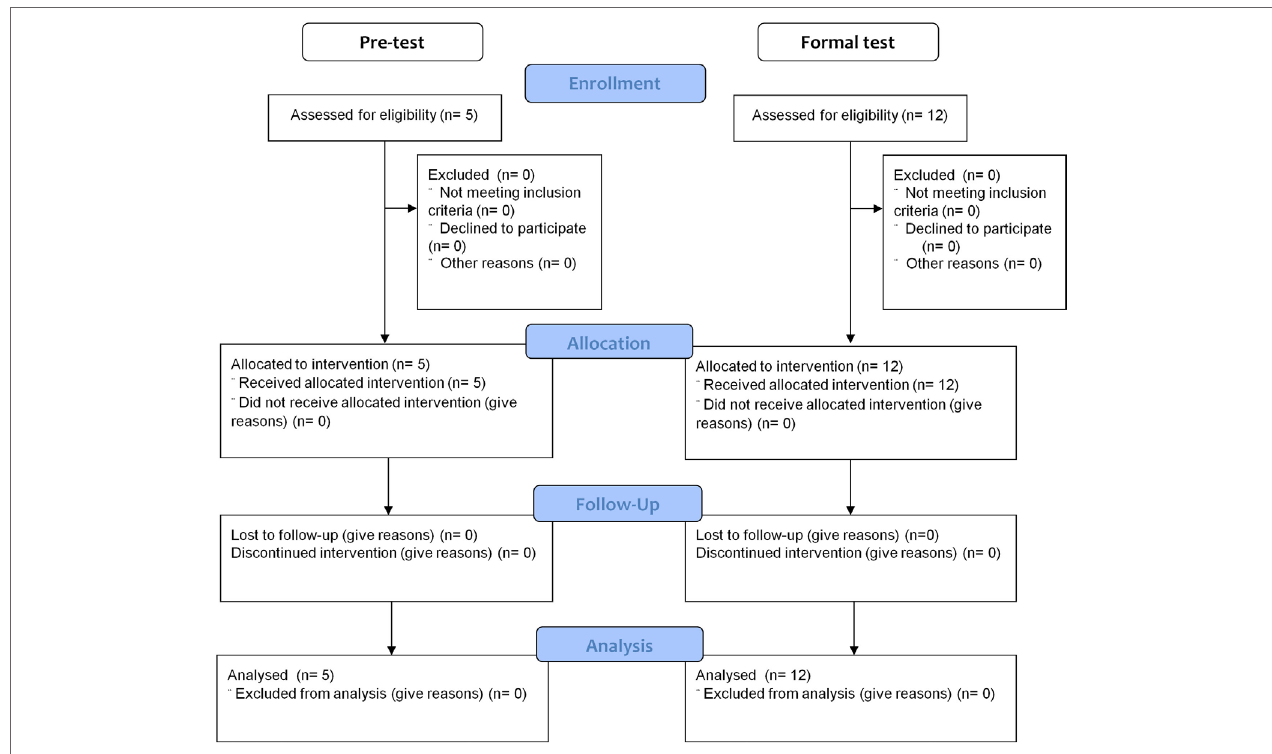
FigUre 3 | The flowchart for subject enrollment, assignment, allocation, follow-up, and analysis for the pretest and formal